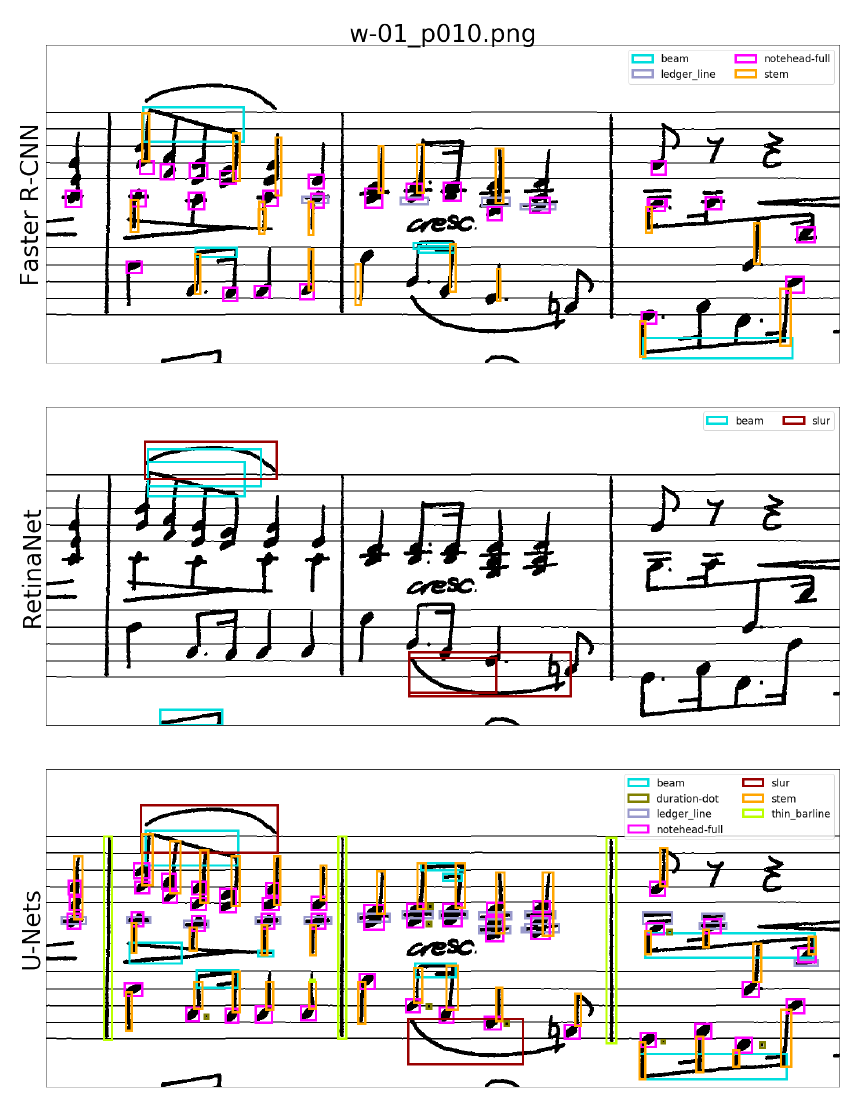
Figure 6. Detection sample on some selected classes from the MUSCIMA++ dataset. ( top – bottom ): Faster R-CNN, RetinaNet, and U-Nets detection